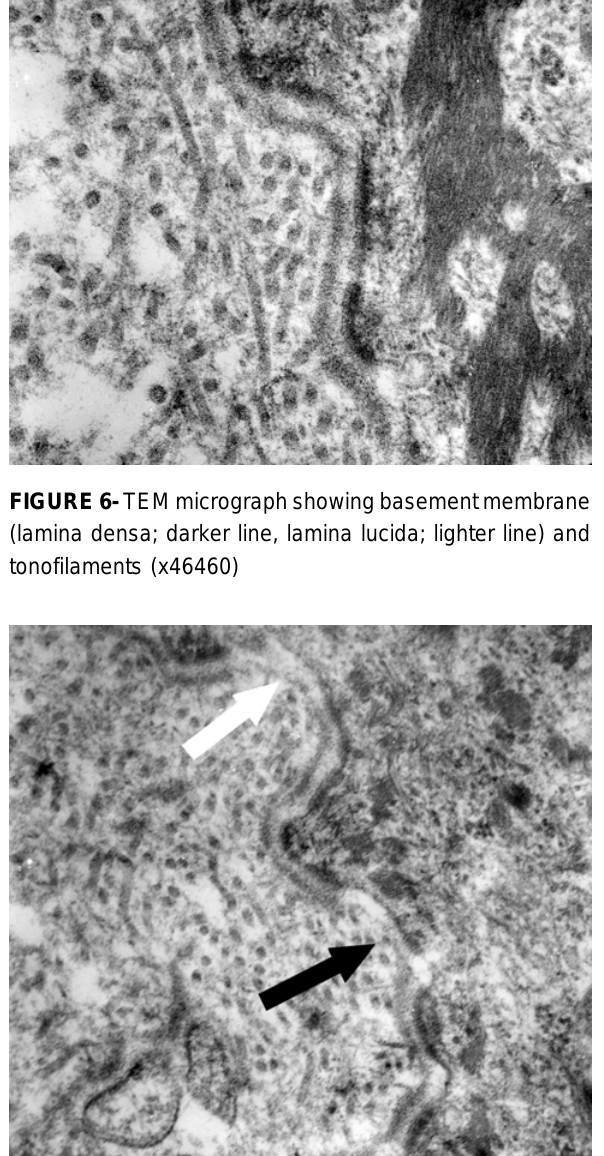
FIGURE 5- TEM micrograph showing tonofilament clumping (arrow) (x27800)